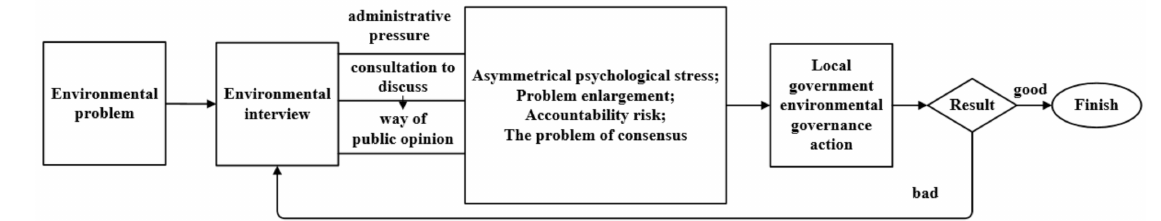
Figure 1. Influence mechanism and process of central environmental consultation on local